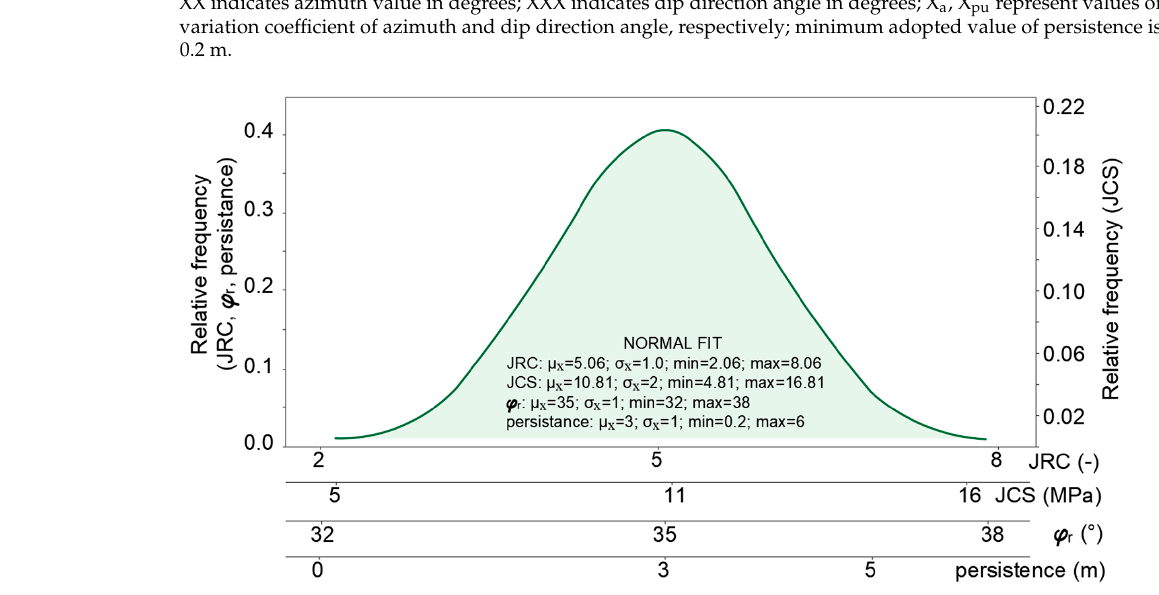
Figure 8. Normal distribution function of input variables (joint roughness coefficient, joint compres- sive strength, residual angle of shear resistance and joint persistence) and characteristic values.